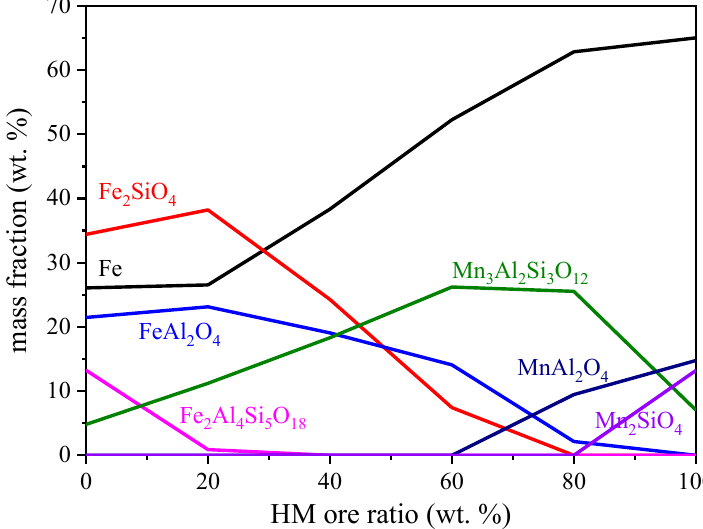
Figure 14. Thermodynamic simulation of a system consisting of Fe 2 O 3 , CO, SiO 2 , Al 2 O 3 and MnO (with different high-manganese iron ore (HM ore) ratio) carried out at 1050 °C in CO atmosphere at ambient pressure.